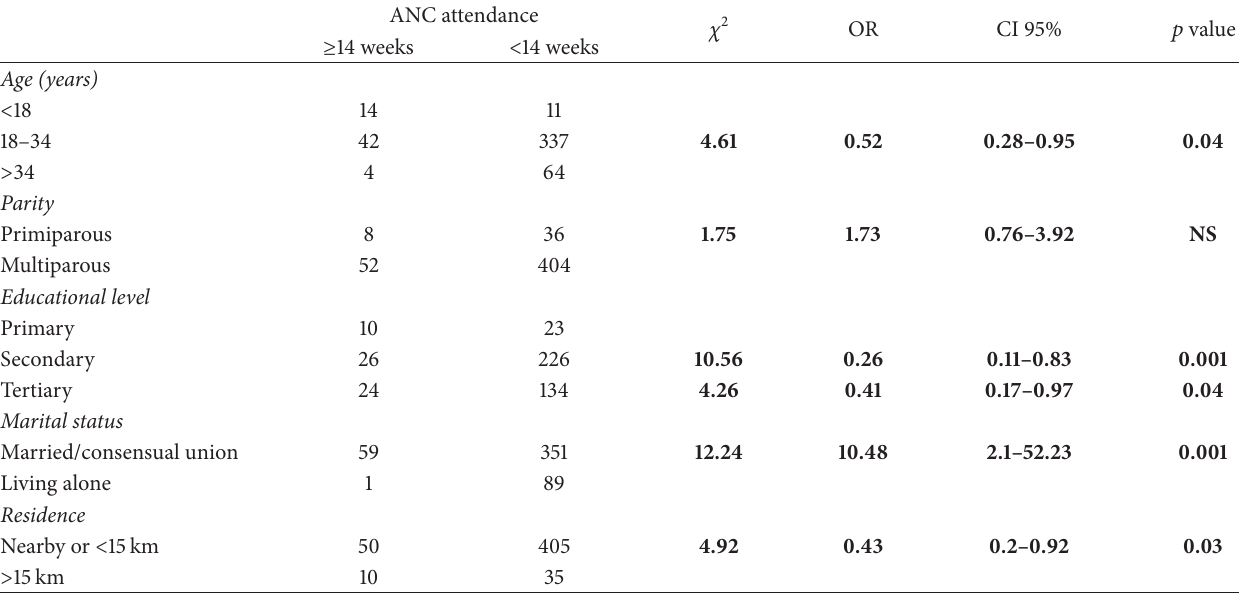
Table 2: Relationship between ANC visits and individual factors ( 𝑛 = 500